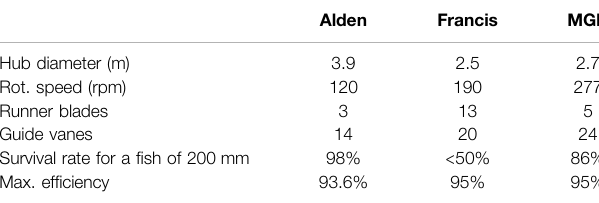
TABLE 1 | Comparison of Various Turbines for Fish Survivability (based on a 13.6 MW unit, Nielson et al., 2015).